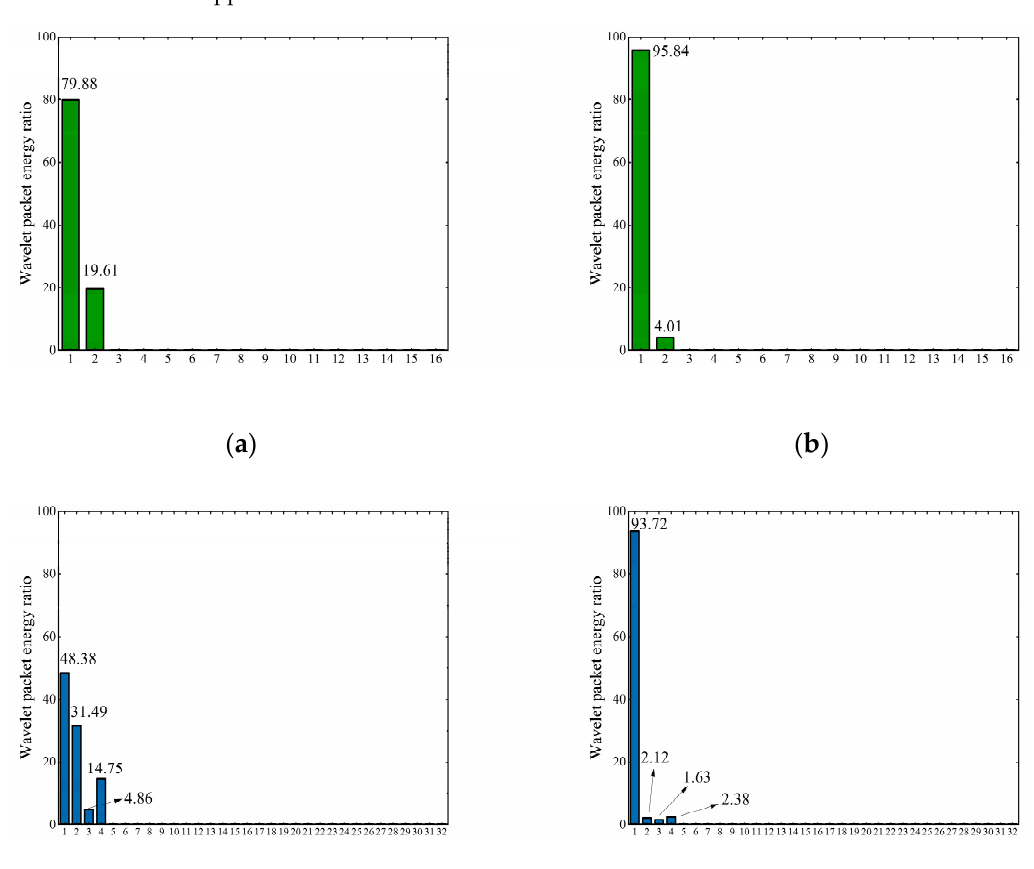
Figure 7. Wavelet packet energy ratio: ( a ) undamaged four-layer wave packet energy; ( b ) damaged four-layer wave packet energy; ( c ) undamaged five-layer wave packet energy; ( d ) damaged five-layer wave packet energy.